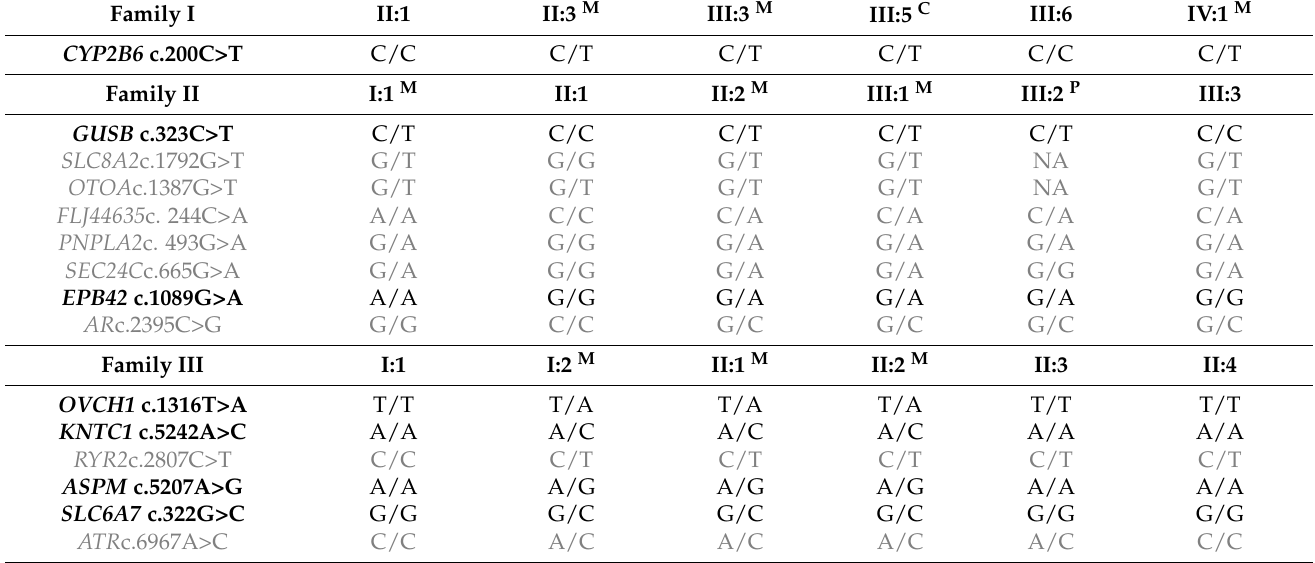
Table 2. Genotypes of the identified variants. Variants co-segregating with FMD are bolded. Variants for which co-segregation was not established are marked with a light gray